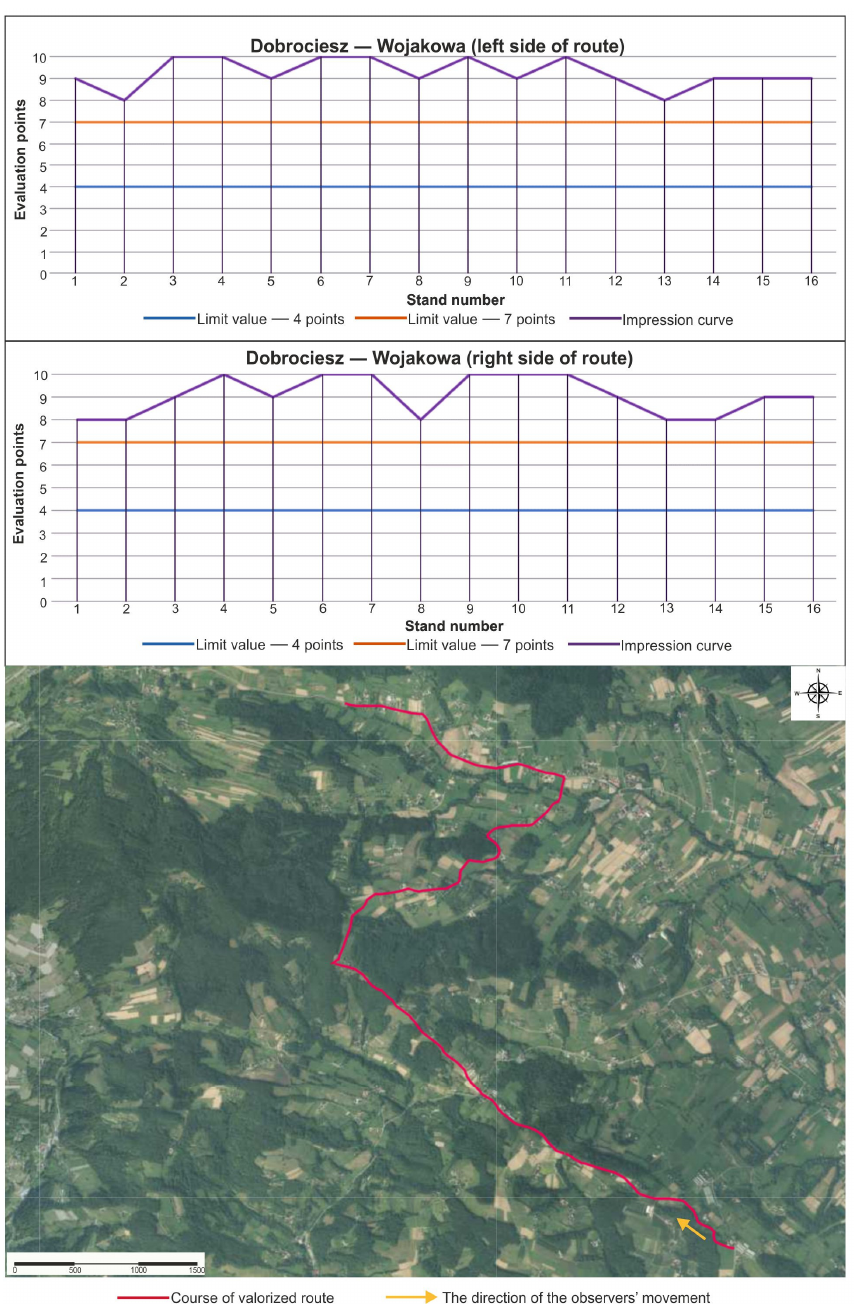
Figure 16. Impression curves for the Dobrociesz—Wojakowa route (Iwkowa Commune).